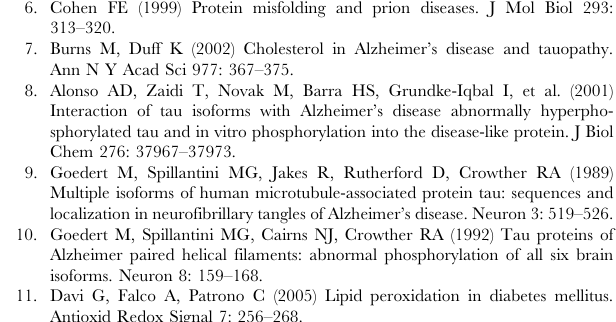
Figure S3 Crosslinking of tau in glutaraldehyde solutions at different concentrations. Conditions are referred to Figure 1, except that the formaldehyde was replaced by glutaraldehyde as a positive control. The images are not shown here, but the mean values of the horizontal diameters of observed neuronal tau (Curve 1) and BSA (Curve 2) particles against the glutaraldehyde concentration are displayed. Found at: doi:10.1371/journal.pone.0000629.s003 (0.08 MB EPS)